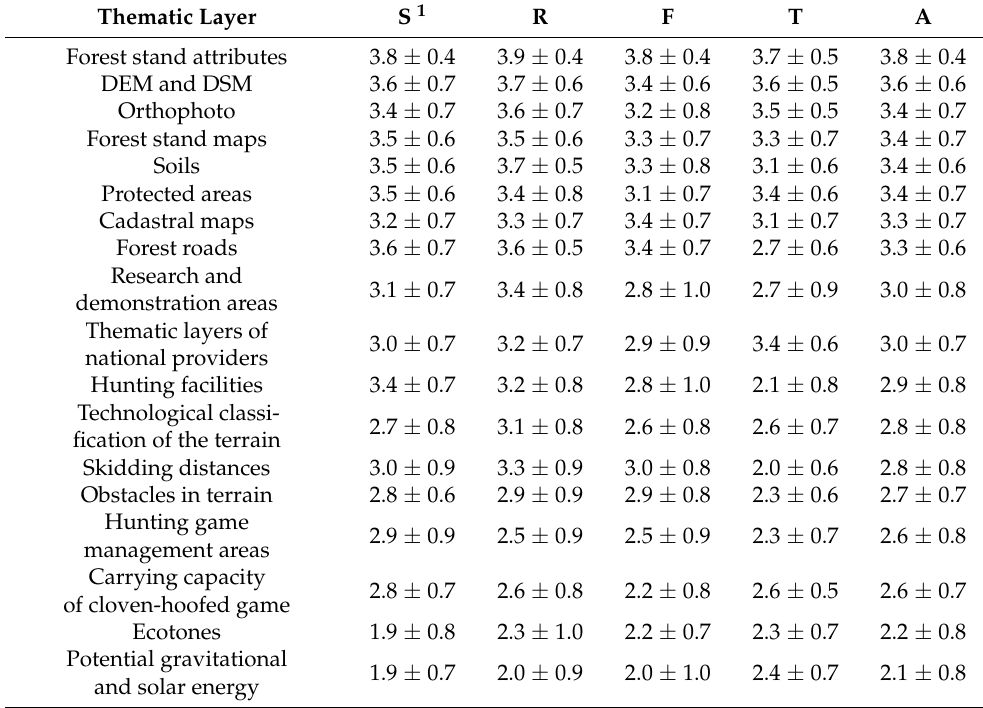
Table A5. Importance of geographic